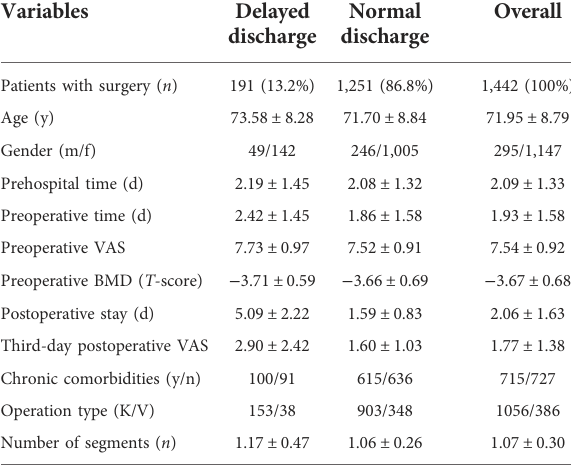
TABLE 1 Clinical information and characteristics of